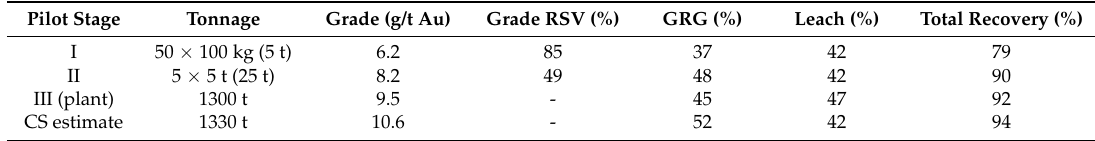
Table 17. Grade and gold recovery values for bulk sampling programme Phases I to II compared to development